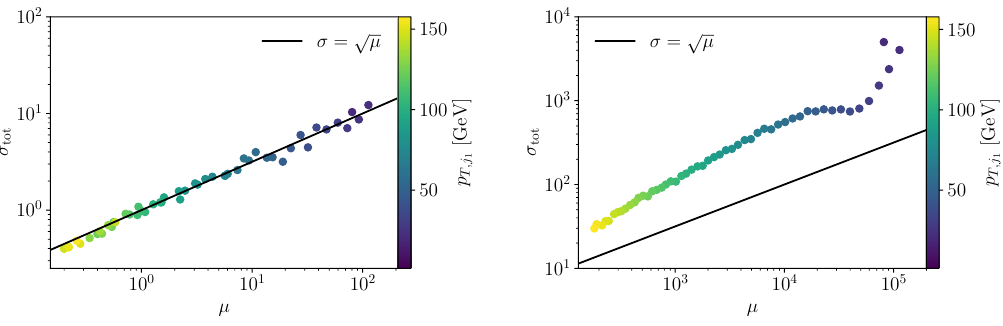
Figure 10: Correlation between event count and BINN uncertainty for 1000 (left) and 1M (right) generated events. The diagonal like defines the Gaussian scaling for a statistically limited